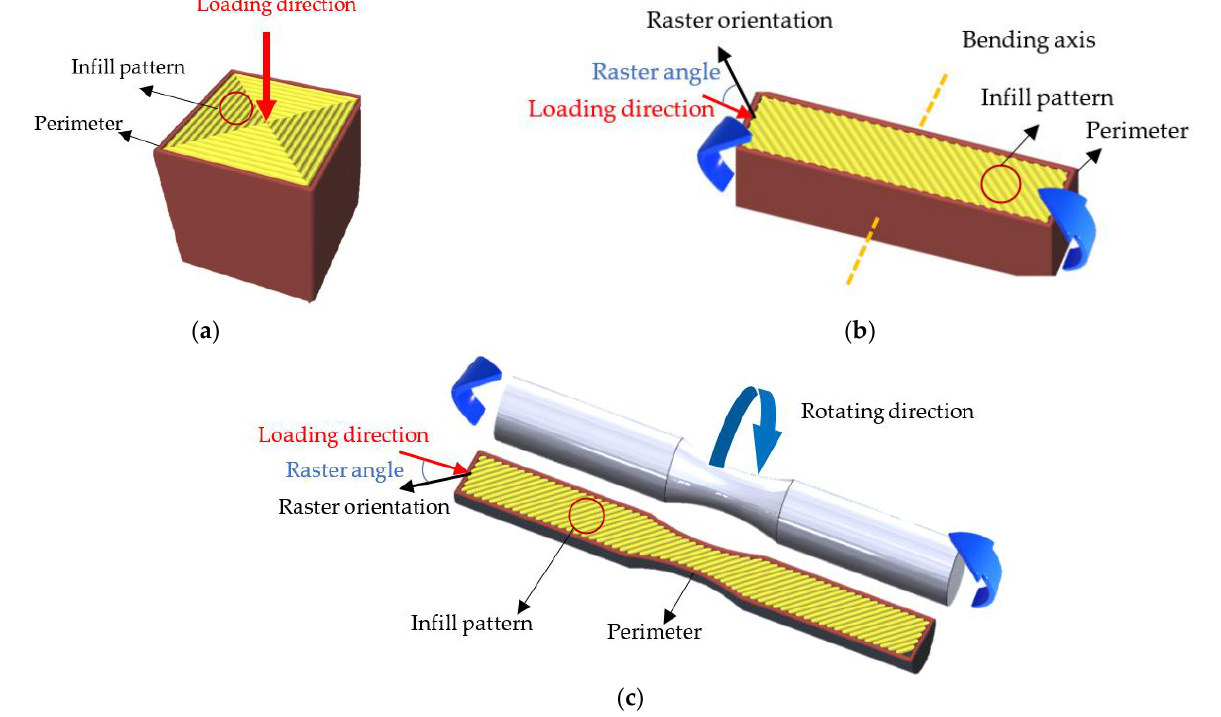
Figure 5. Illustration of raster orientation and loading direction in ( a ) compressive ( b ) flexural, and ( c ) rotating bending specimens. Since extruded filaments and the loading direction are not co-planar in the pure compression state, the raster angle is not defined for compressive specimens.